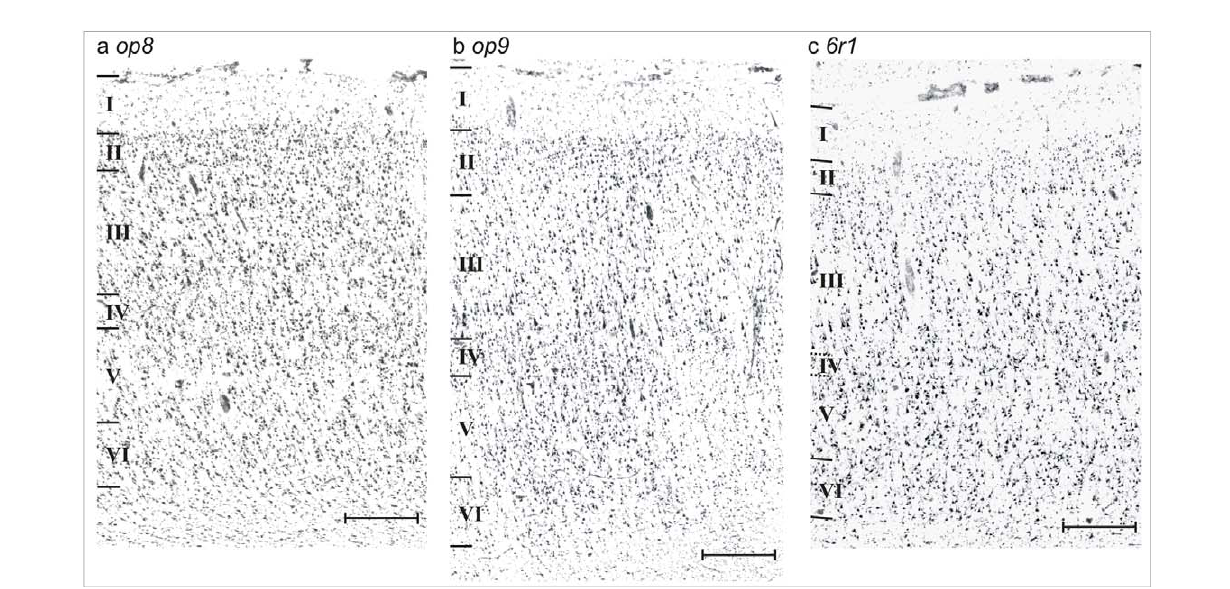
Figure 2. Photomicrographs of cell body–stained cryostat sections of areas op8 (a), op9 (b), and 6r1 (c). The frontal opercular areas op8 and op9 are both dysgranular (i.e., thin lamina IV). The cell packing density was slightly larger in area op8 than in area op9 . Area 6r1 has an even thinner layer IV; it is almost agranular. Its laminar pattern is weak. In contrast to ventral area 6 and Broca’s area 44 it contains smaller pyramidal cells in lamina III. Scale bar, 0.5 mm. Roman numerals indicate the cortical layers.